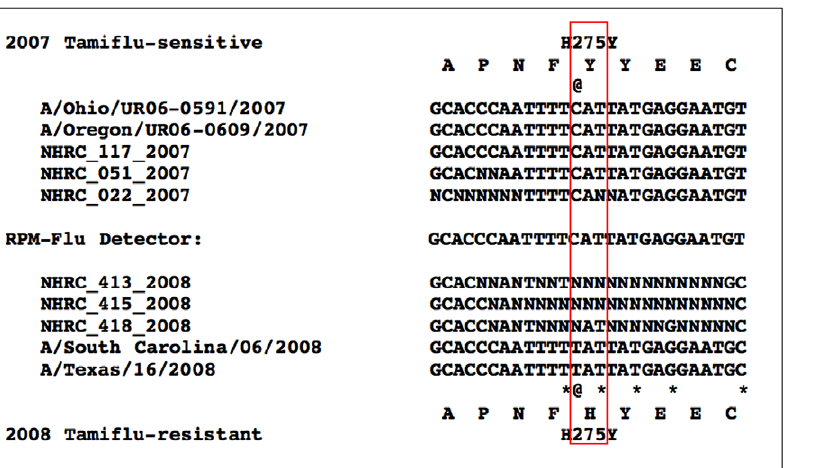
Figure 4. Comparison of RPM-Flu assay-generated NA1 (neuraminidase) gene sequences from two ensembles of clinical specimens, collected in 2006–2007 and in 2008, respectively. The older specimens have NA1 gene sequences that are concordant with those of the oseltamivir-sensitive, A/New Caldedonia/20/1999 (H1N1) RPM-Flu detector tile strain, including the determinant –CAT– histidine (H) codon at peptide position 275 (aligned locus in red box). BLAST analysis of these NA1 gene sequences returned most similar records including the oseltamivir-sensitive A/Ohio/UR06-0591/2007 and A/Oregon/UR06-0609/2007 strains. The ‘@’ symbol in the inset indicates the C-T transition mutations encoding tyrosine (Y) at this locus of more recent strains such as A/South Carolina/06/2008 and A/Texas/16/2008. Three specimens (NHRC_413, _415, and _418) were also collected in 2008, and these failed to generate sequence through this locus from the oseltamivir-sensitive detector tile genotype. These results do not explicitly corroborate the H275Y resistance genotype, although they are consistent with diminished re-sequencing efficiency at sites of mismatching detector tile and specimen gene sequences. These runs of N-calls suggest two or more proximal nucleotide mismatches may be present at this NA1 gene locus of the selected NHRC 2008